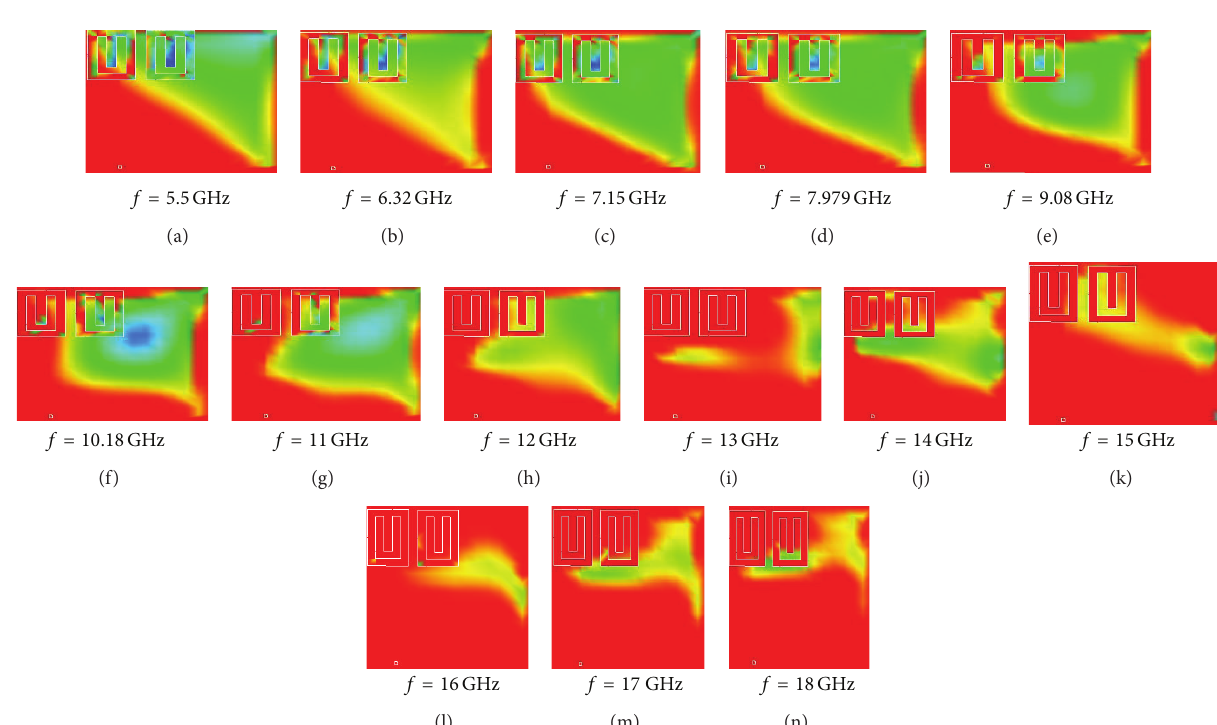
Figure 7: Gain versus frequency.